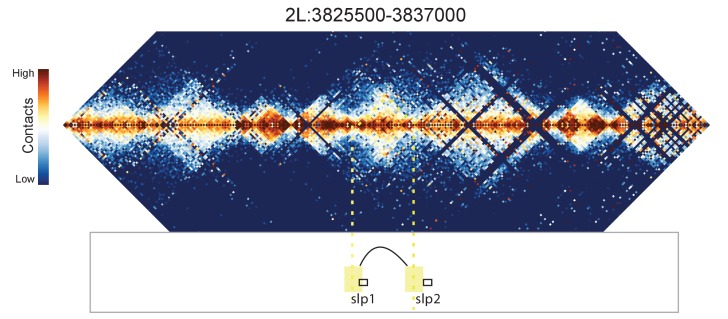
Hi-C map for the locus spanning 2L:3825500-3837000.A weak looping interaction is seen between the 5' ends of slp1 and slp2.